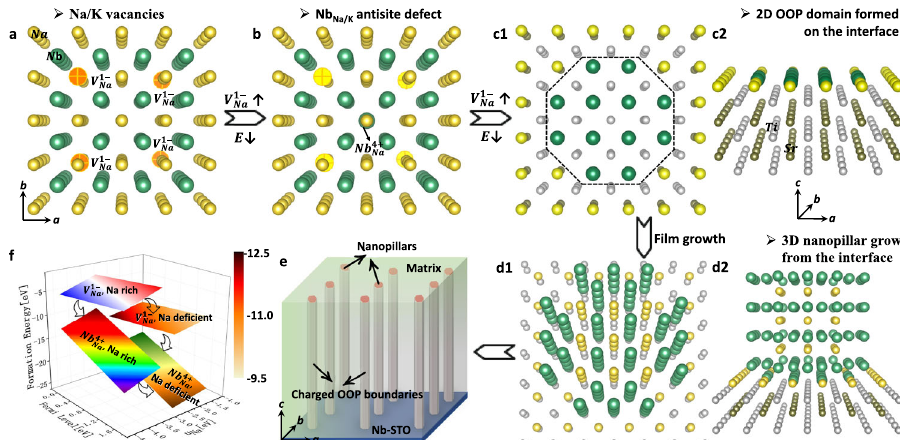
Fig. 1 Strategy for the formation of nanopillars with charged OOP boundaries for giant effective piezoelectricity in alkali niobate fi lms. a, b Atomic models showing 0D Na vacancies and one Nb Na antisite defect replacing the vacancies. c1 , c2 Two views of the atomic model showing the interface with 2D OOP domain grown on the STO substrate for the fi rst layer of the fi lm. d1 , d2 Two views of the atomic model showing a 3D nanopillar grown on STO substrate for the following fi lm growth. e Schematic for nanopillars with charged OOP boundaries embedded in the matrix. f Calculated defect formation energies for Na vacancies and Nb Na antisite defect, as a function of Na chemical potential and Fermi level. O atoms are not shown in the structural models for